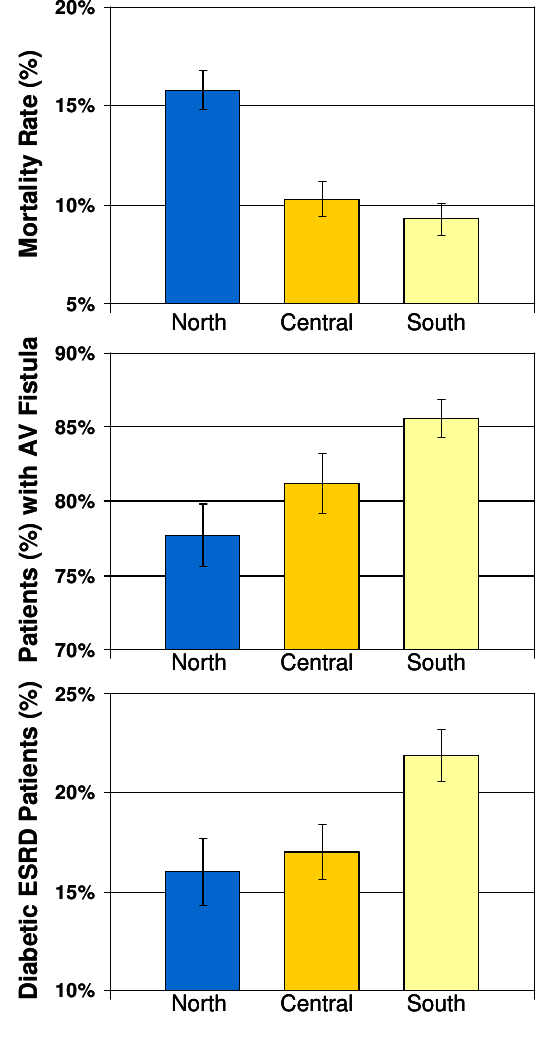
FIGURE 2. Geographic regional